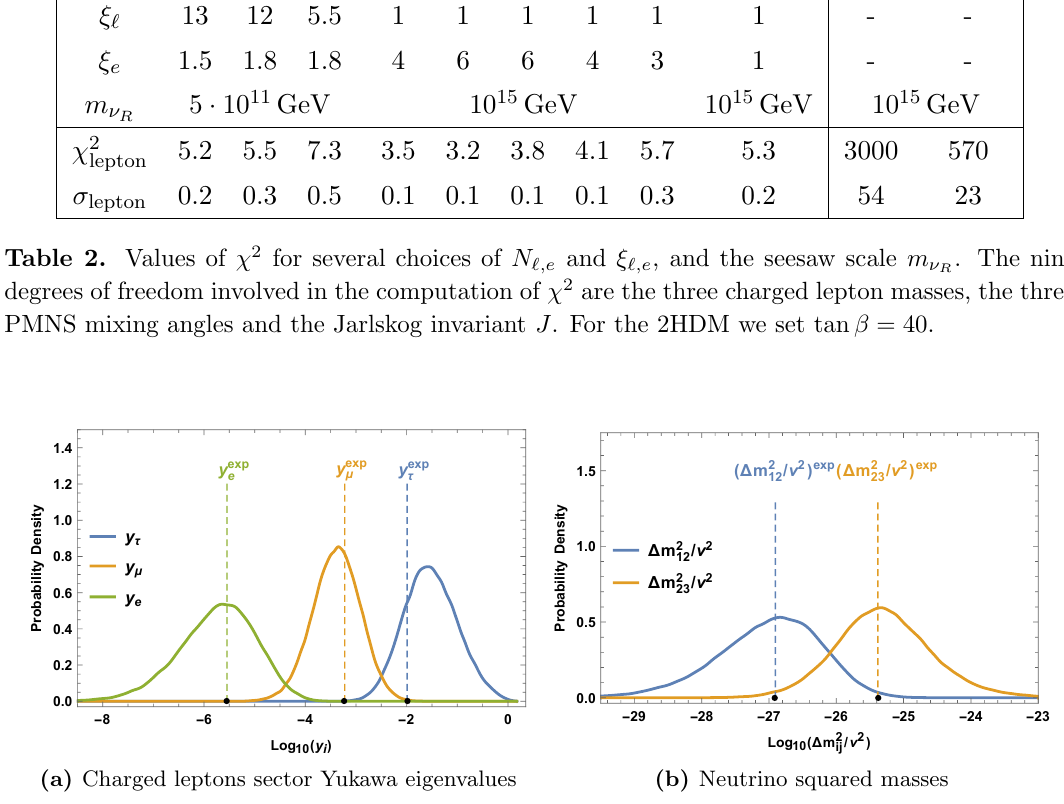
Figure 7. Lepton masses distributions for N ‘ = 2, N e = 5, (cid:24) ‘ = 1 and (cid:24) e = 4. Both neutrinos and charged leptons masses are very well reproduced.